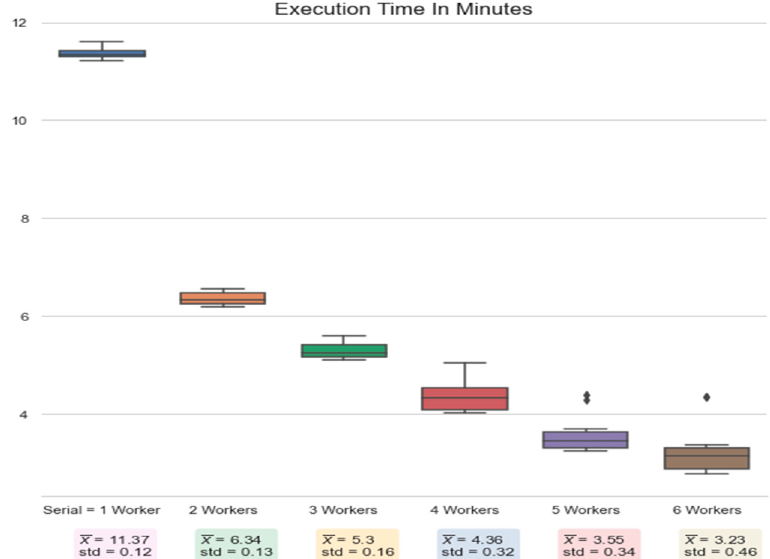
Figure 21. Visualization for execution time in minutes. Figure 21 represents the mean and standard deviation for each class. While it takes in average 11:37 min (697 s) to execute 256 different models with one core, and for six workers it takes 3:23 min (203 s) in average, this approach (parallel processing) runs 3.4 faster than a serial–manual optimizing technique.